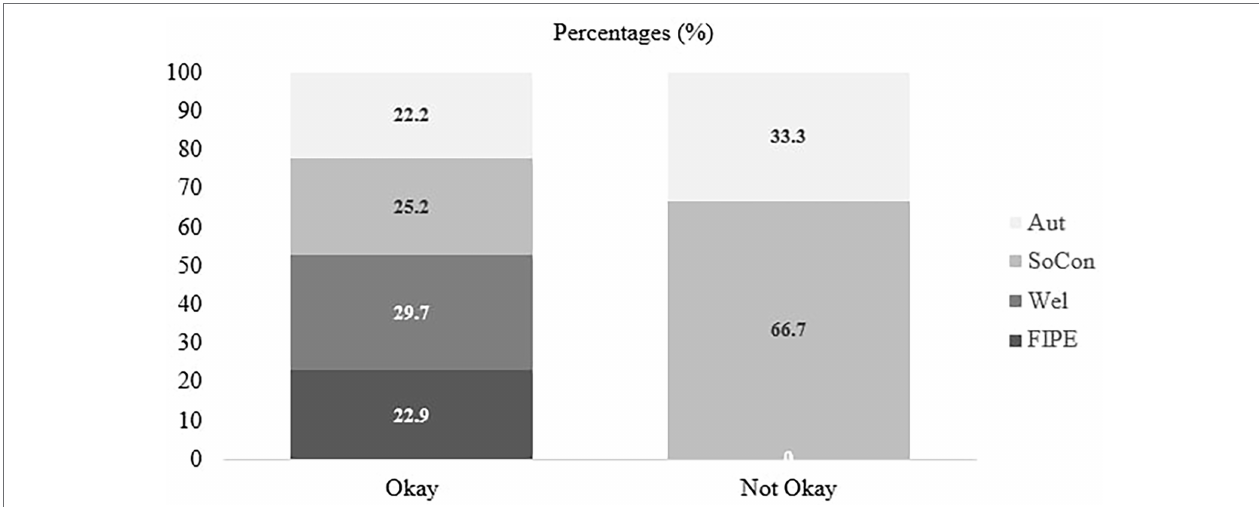
FIGURE 3 | Percentages of participants reasoning of individual evaluation of challenger by individual evaluation (okay, not okay). FIPE, Fairness and Individual Rights and Prejudice and Equality; Wel, Welfare; SoCon, Social and Group Norms, Group Dynamics and Functions and Repercussions and Representation Management; and Aut, Autonomy. Numbers represent the percentages of participants within “okay” and “not okay”